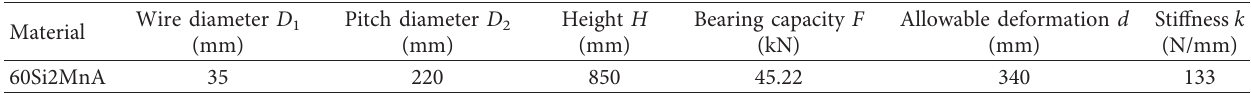
Figure 1: Schematic diagrams and physical diagrams of combined isolation devices. (a) Schematic diagram of TQGG. (b) Schematic diagram of TXJG. (c) Schematic diagram of TPMLG. (d) Physical diagram of TQGG. (e) Physical diagram of TXJG. (f) Physical diagram of TPMLG. Table 2: Main parameters of steel